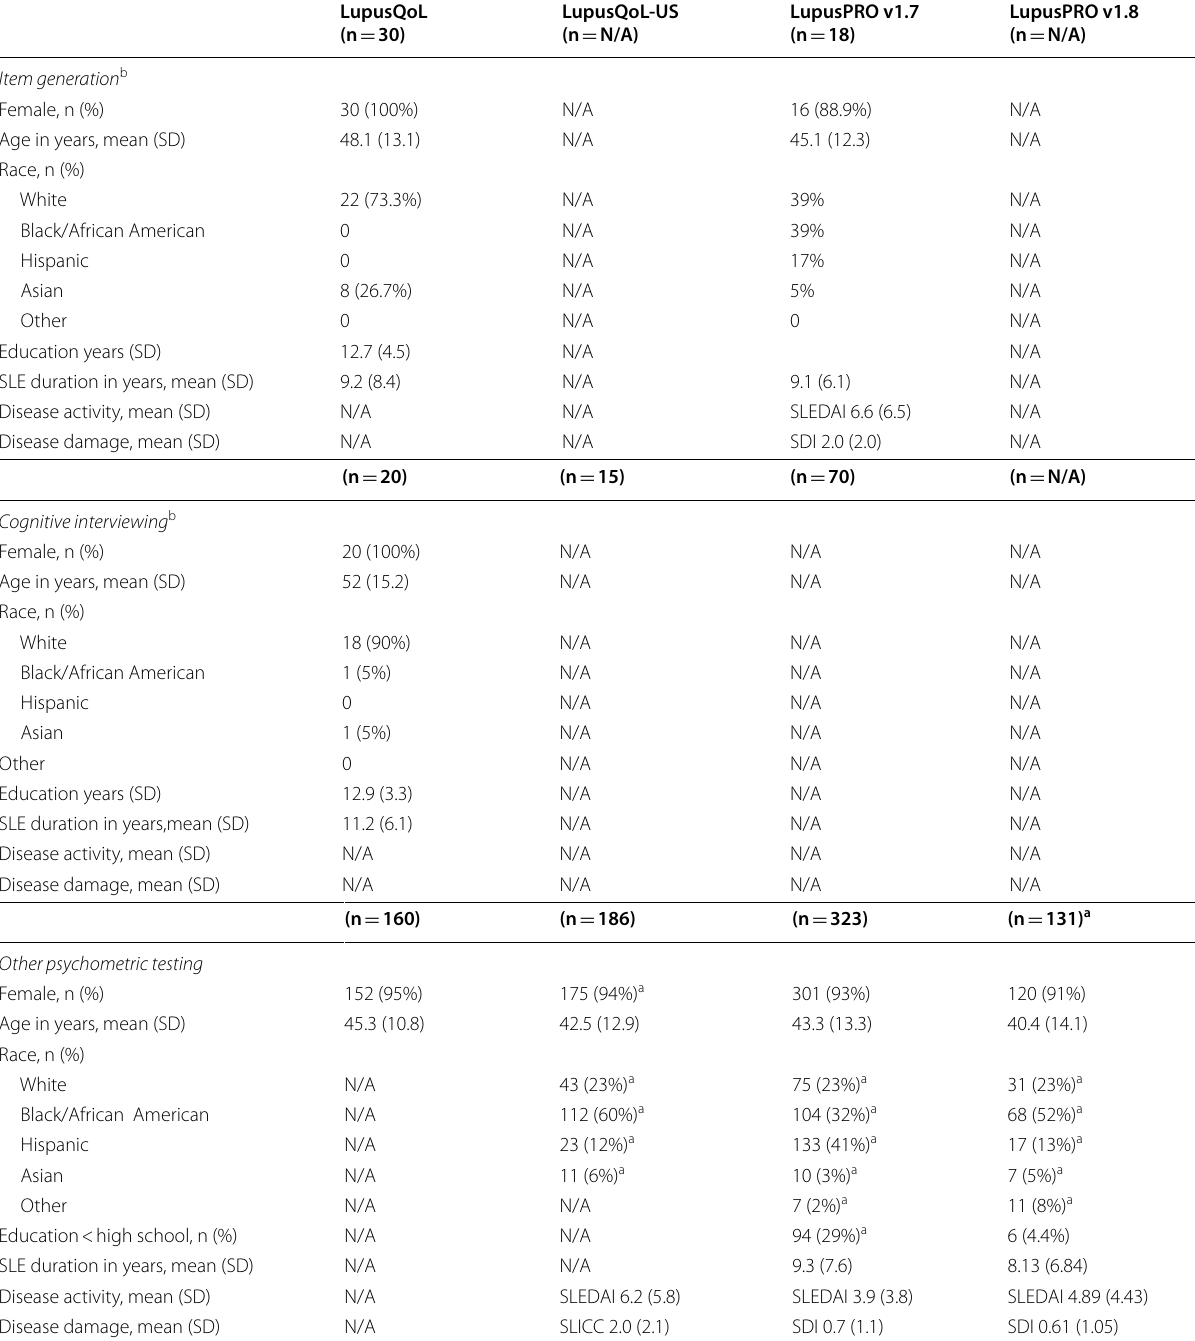
Table 2 Study population characteristics of SLE population used in the development and validation of SLE‑PRO